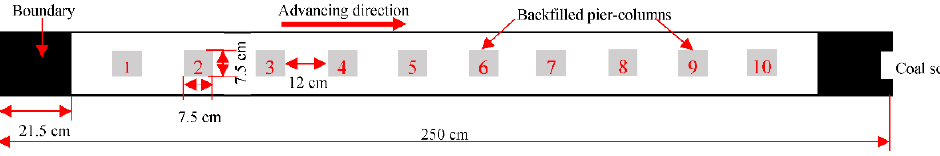
Figure 7. The positions of the pier-columns.